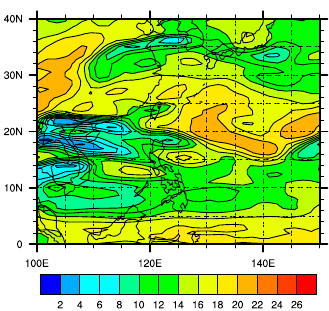
Figure 5. Wind speed nephogram at the landing of the typhoon.